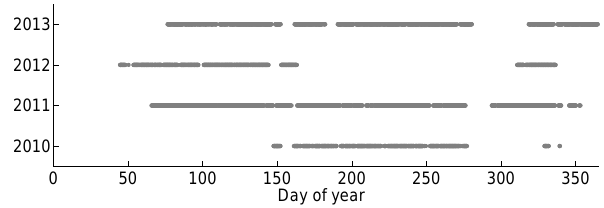
Figure 1. Grey dots show VOC flux data coverage for each